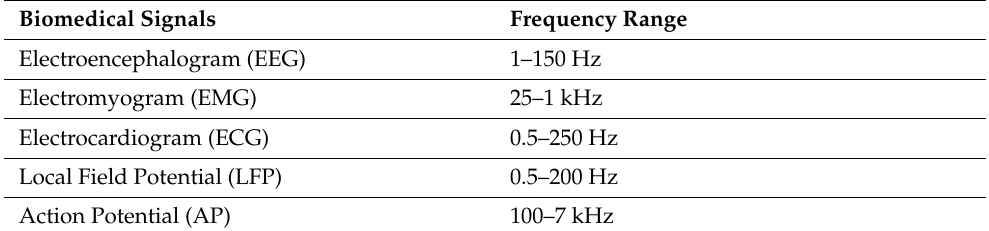
Table 1. The frequency range of various biomedical signals.